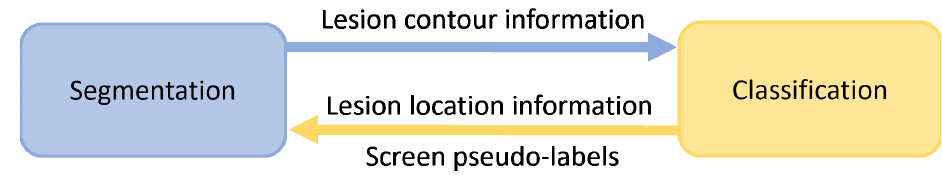
Figure 1. The correlation between skin lesion segmentation and classification tasks. Segmentation can provide the contour information of lesions for classification. Classification can generate class activation maps to provide the location information of lesions for segmentation. Classification also can be used to screen pseudo-labels for